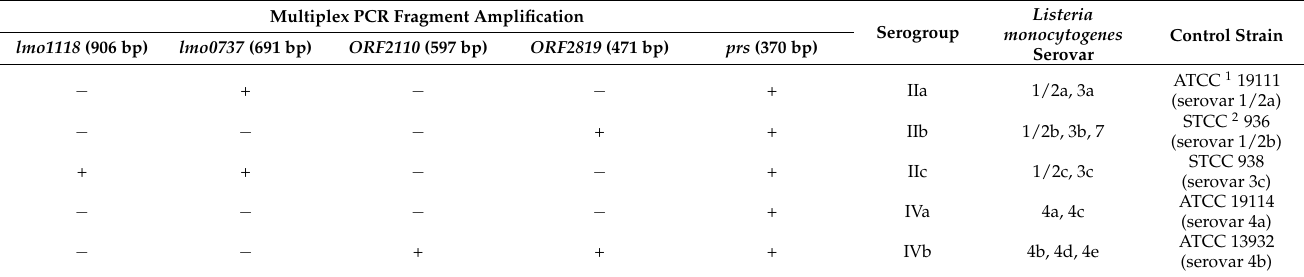
Table 7. The correlation of multiplex PCR and conventional serotyping for Listeria monocytogenes